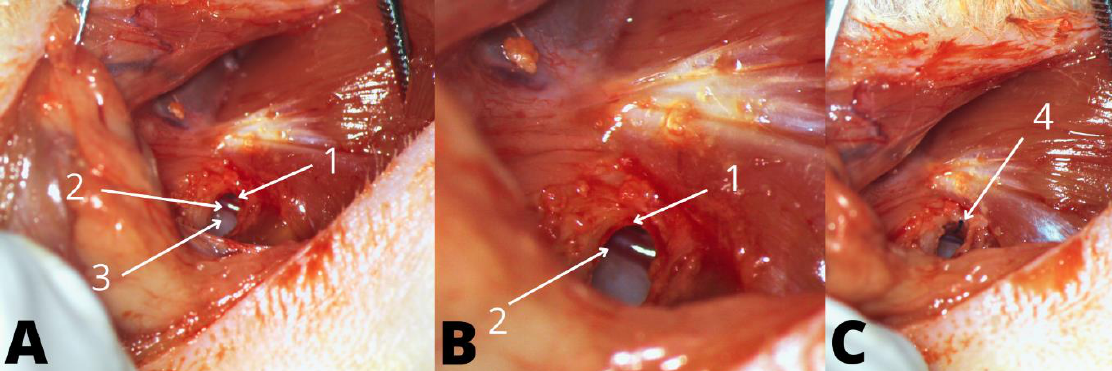
Figure 1. Left ear electrode analog insertion; 1—round window niche; 2—stapedial artery; 3—middle ear, seen through the bony defect; 4—electrode analog during the insertion through the round window membrane. ( A ): Opening of the left middle ear, ( B ): Visualization of the RW, ( C ): Left ear electrode analog insertion.